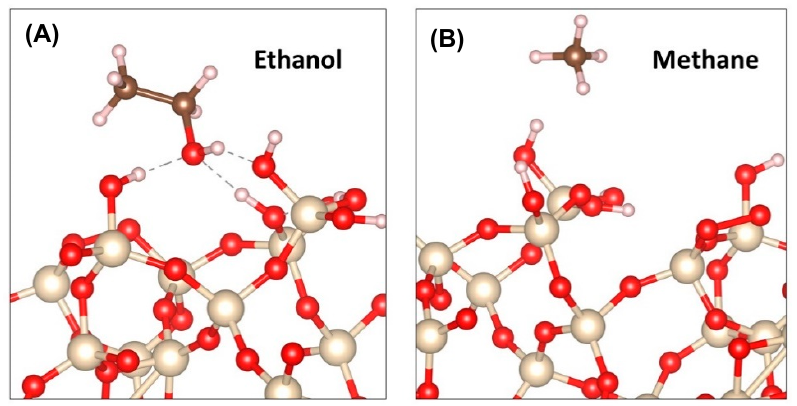
Figure 4. Preferential configuration of ( A ) ethanol and ( B ) methane molecules adsorbed on the surface of amorphous SiO 2 nanoparticle.